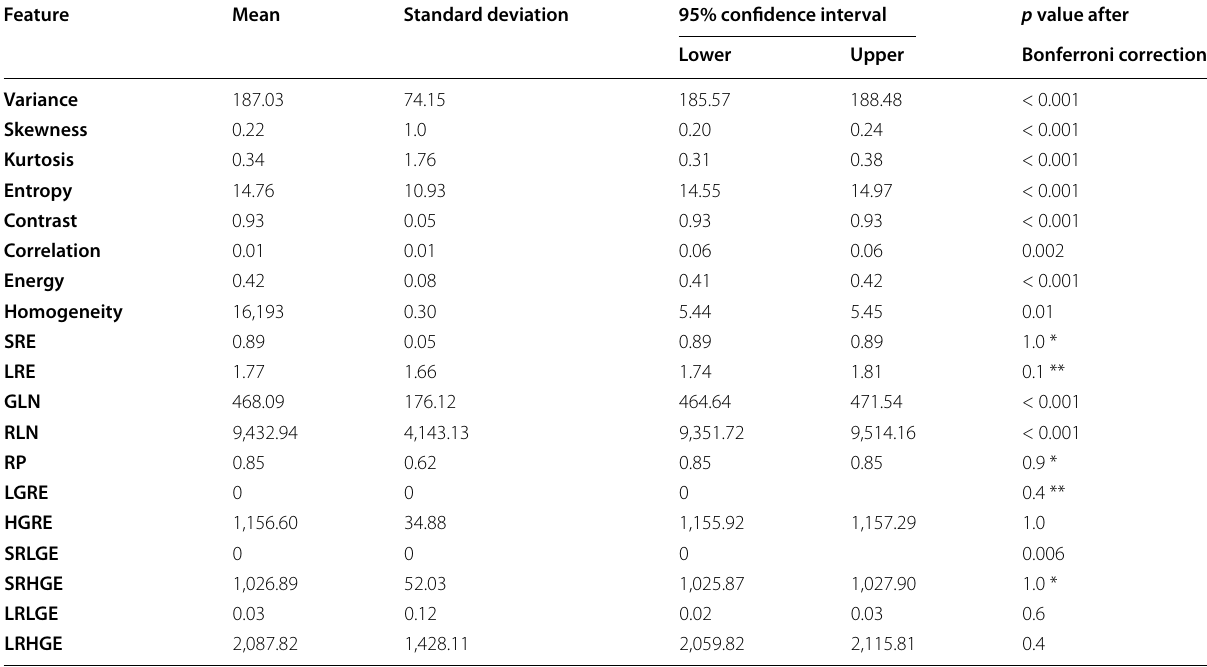
Table 2 Texture feature descriptives and p values for post hoc Bonferroni correction for each feature